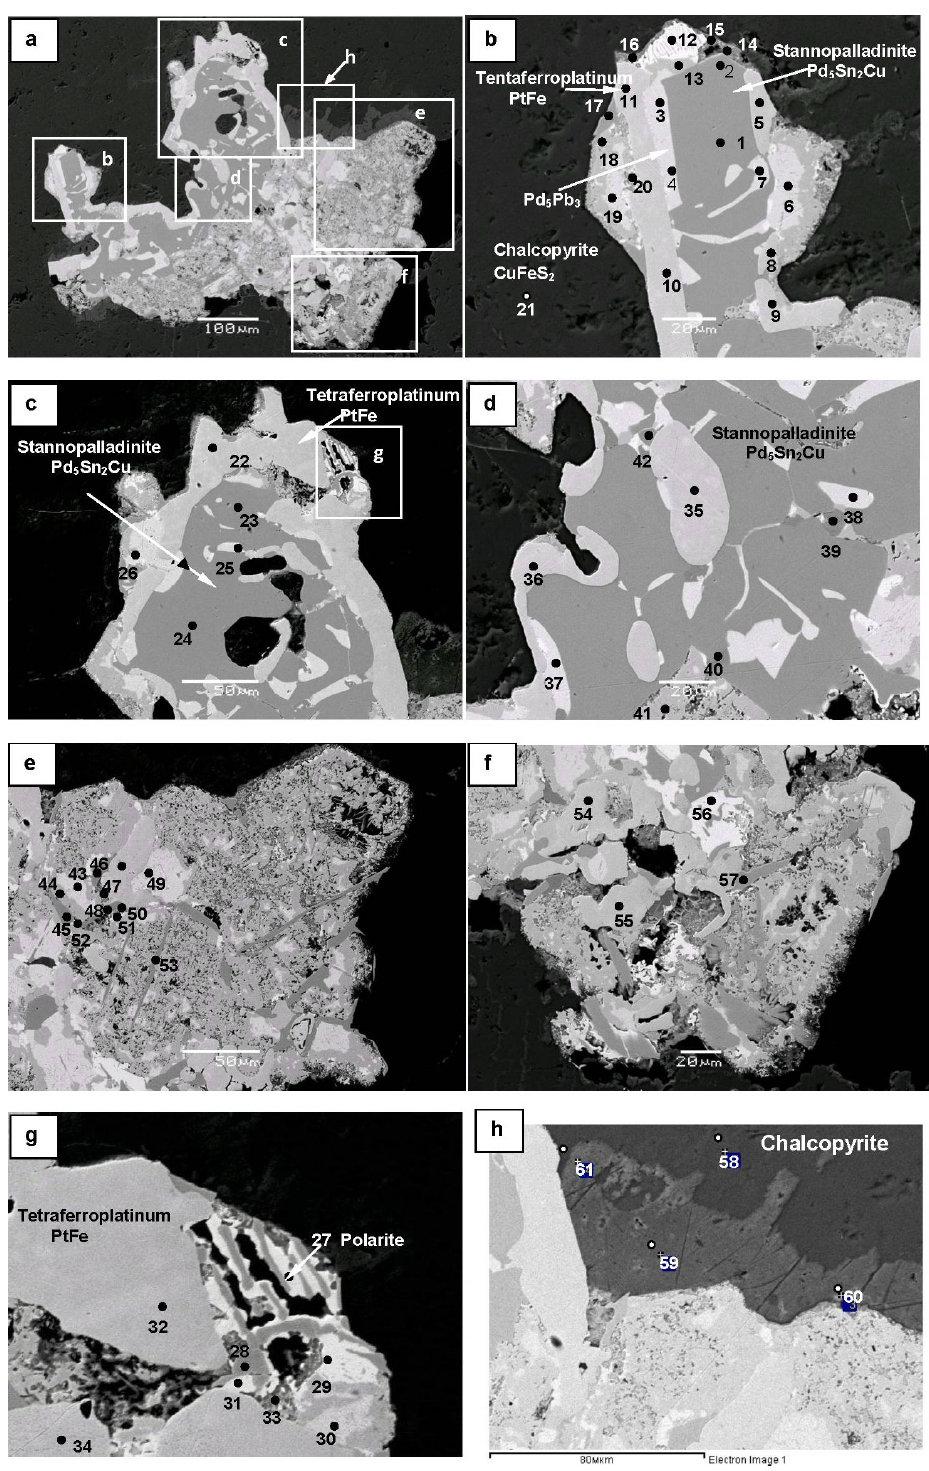
Figure 15. Microaggregate of PGM in chalcopyrite. BSE images. Points are correspond to N analyses in Table 11. ( a )—positios of photos given in figures b – h ; ( b )—rim of Pd 5 Pb 3 and tetraferroplatinum around stannopalladinite, ( c )—rim of tetraferroplatinum around stannopalladinite, ( d )—aggragate of stannopalladinite with tetraferroplatinum and zvyagintsevite inclusions, ( e )—microporous agraggate of platinum-group minerals with stannopalladinite and tetraferroplatinum crystals, ( f )—stannopalladinite, tetraferroplatinum and Pd 5 Pb 3 grains in microporous agraggate of platinum-group minerals, ( g )—rims of polarite on stannopalladinite, ( h )—Ag-bearing chalcopyrite on the aggragate of platinum-group